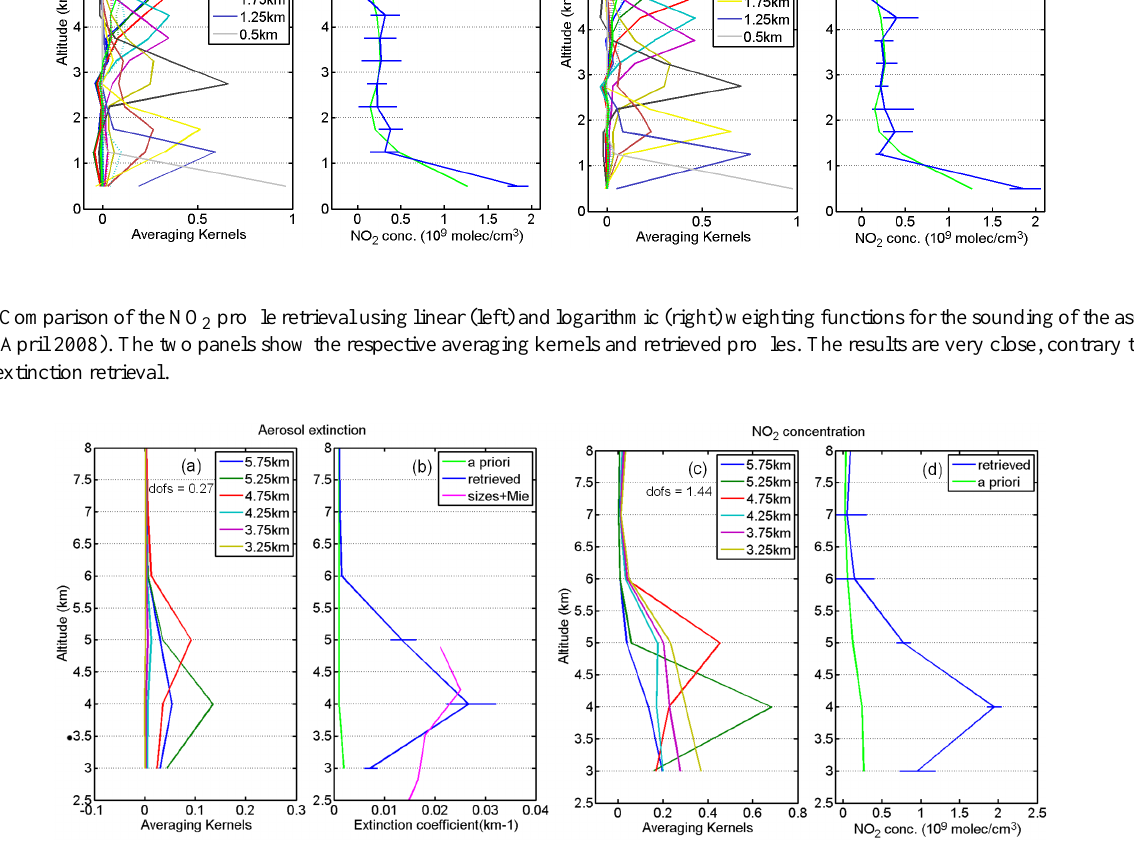
Fig. 12. Retrieved extinction and NO 2 profiles for the sounding of the as0833 flight (9 April 2008). Under 3 km high, the radiative transfer is too strongly affected by clouds to enable quantitative retrievals. Around 4 km high, an enhanced layer is measured for both extinction and NO 2 .